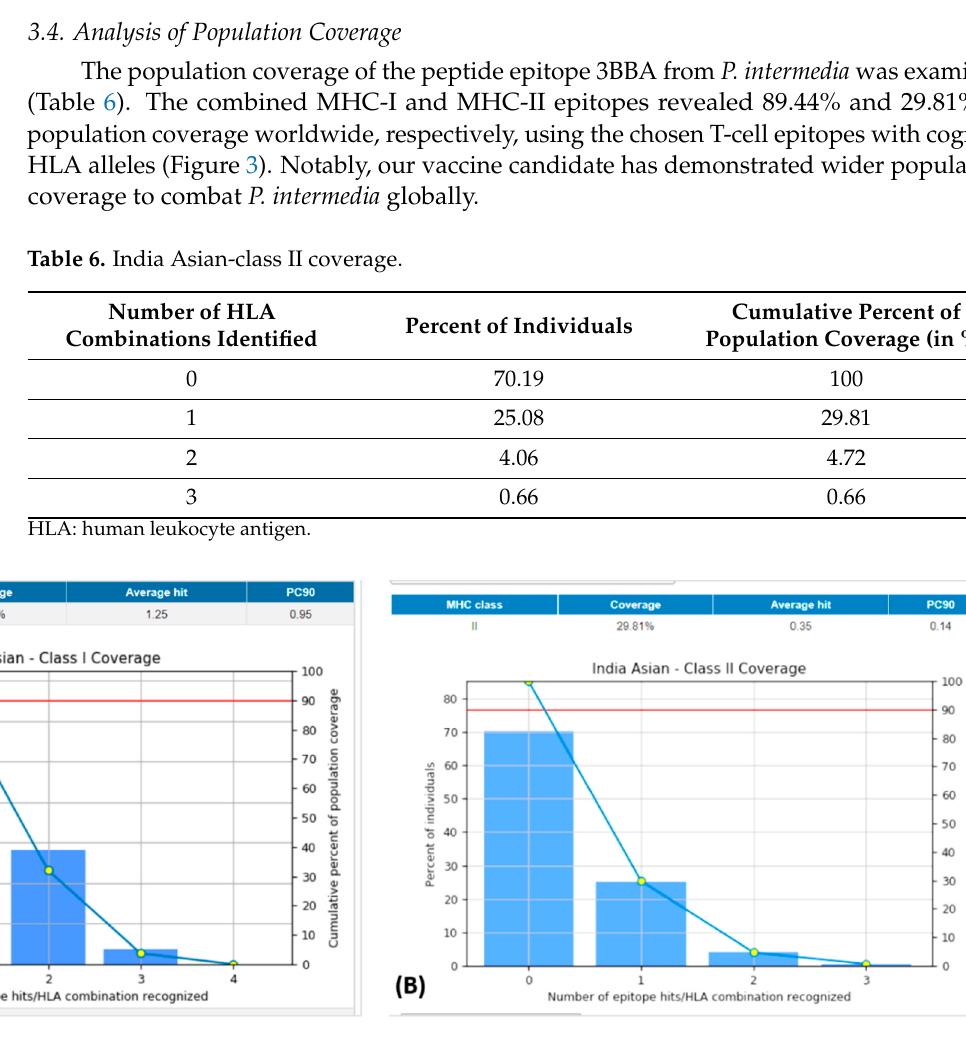
Figure 3. Population coverage of all the selected epitopes for both MHC-I and II classes. ( A ): Indian Asian class-I coverage. ( B ): Indian Asian class-II coverage. MHC: major histocompatibility complex.